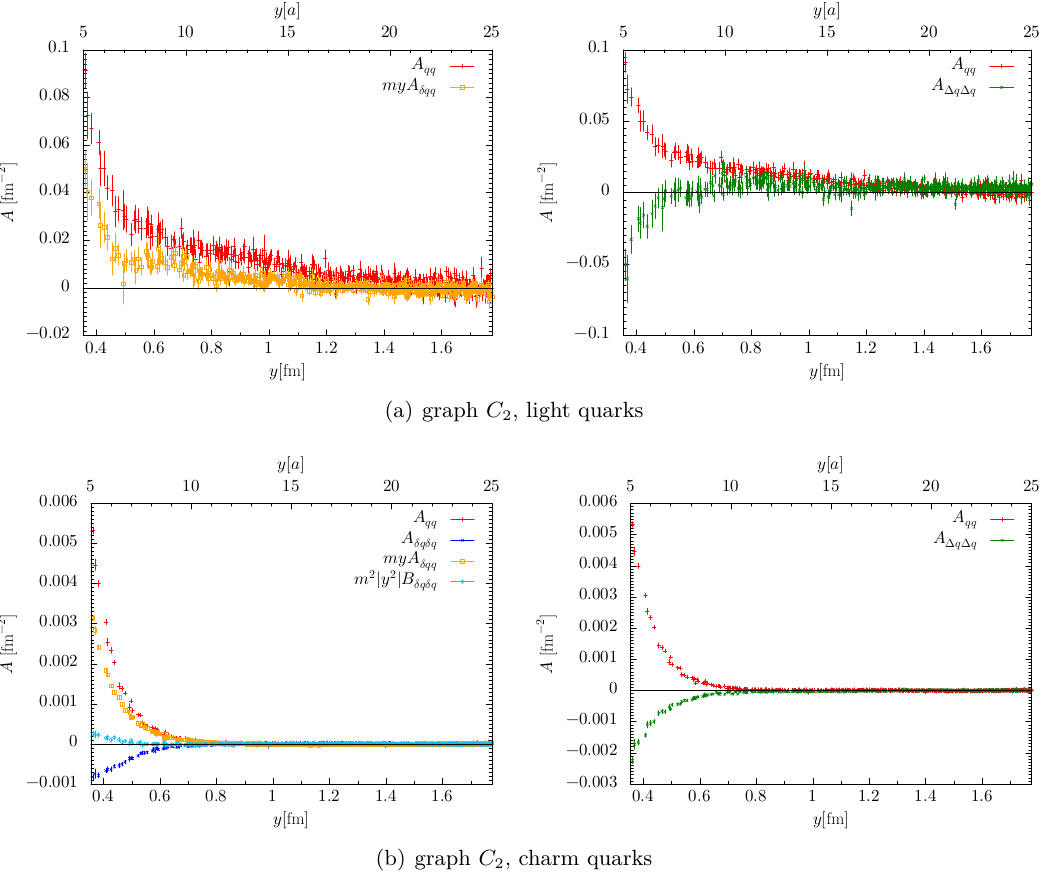
Figure 21 . As figure 20, but for graph C 2 . We have no strange quark results for this case. The light quark data for A δqδq and m 2 | y 2 | B δqδq is very noisy and not shown for the sake of